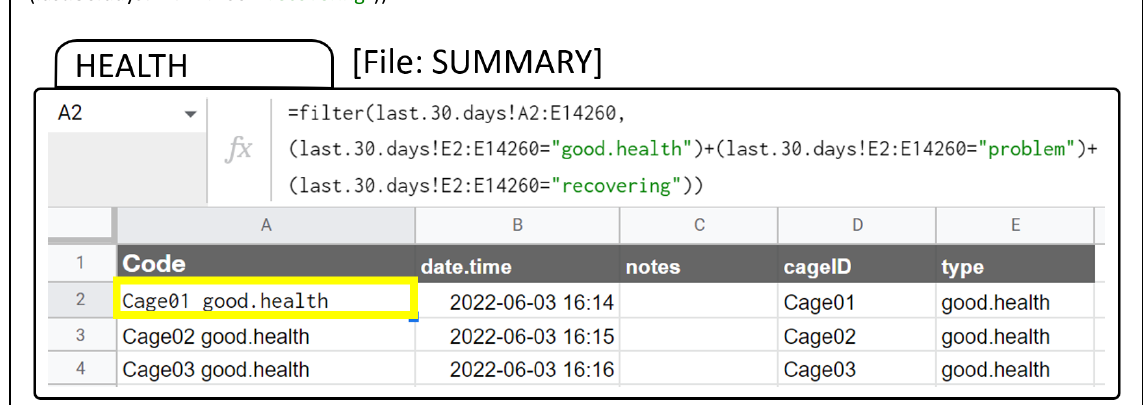
Google Sheet Code to Automatically Filter Recent Data by